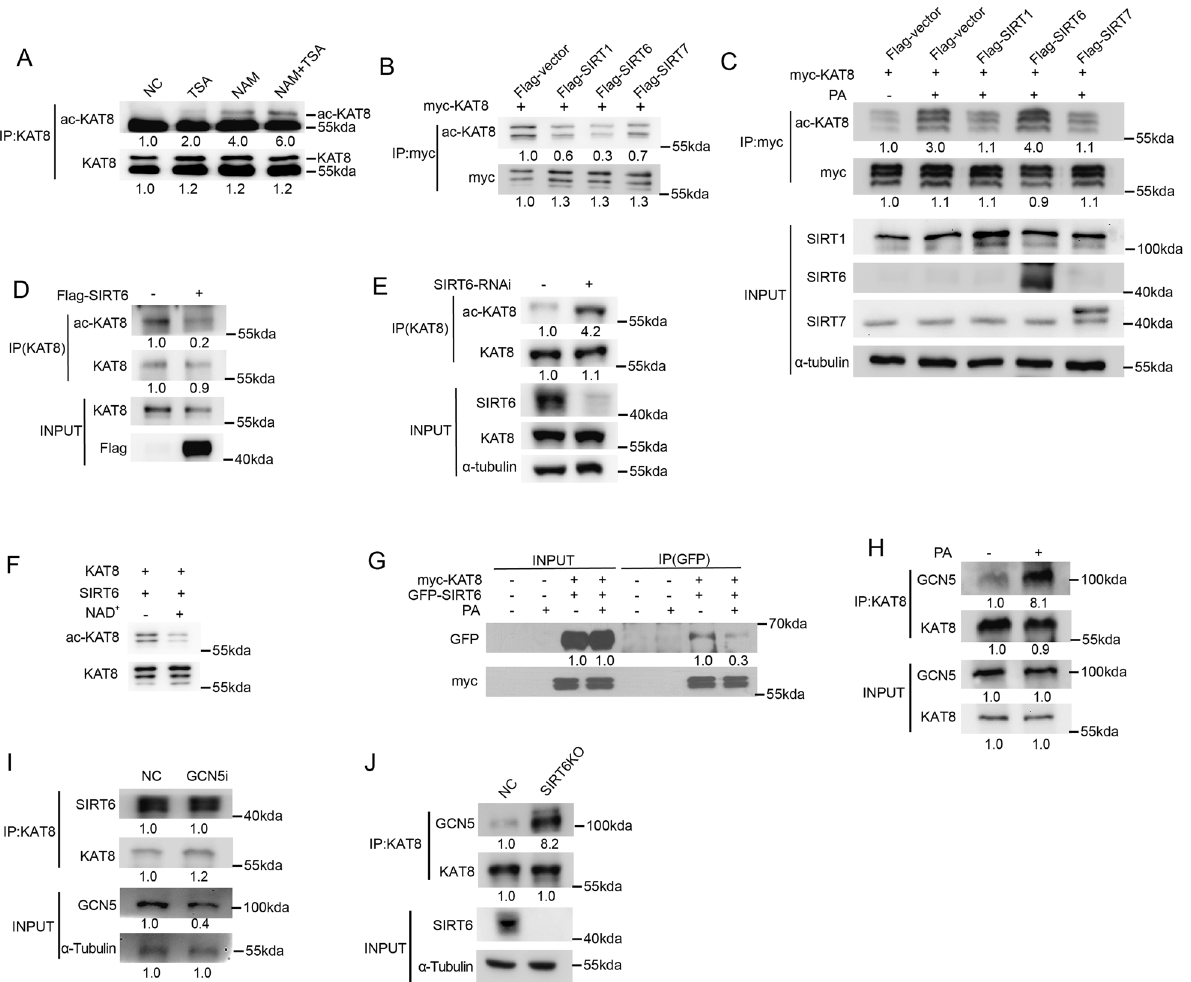
Fig. 3 SIRT6 is a deacetylase of KAT8 and is responsible for KAT8 acetylation. A HCT116 cells were treated with 1 μ M TSA or 5 mM NAM for 8 h and then proteins were extracted for Co-IP assay to detect the level of KAT8 acetylation. B HCT116 cells were co-transfected with myc- KAT8, Flag-SIRT1, Flag-SIRT6 or Flag-SIRT7, and then proteins were extracted for Co-IP to detect the level of KAT8 acetylation. C HCT116 cells were co-transfected with the plasmids above, and then treated with PA at 0.2 mM for 24 h. Proteins were extracted for Co-IP to detect the level of KAT8 acetylation. D , E HCT116 cells were transfected with Flag-SIRT6 ( D ) or SIRT6 siRNA ( E) , and proteins were extracted for Co-IP to detect the level of KAT8 acetylation. F myc-KAT8 and Flag-SIRT6 were co-transfected into HCT116 cells, and then KAT8 and SIRT6 proteins were puri fi ed to perform in vitro deacetylation assay. G , H HCT116 cells were co-transfected with GFP-SIRT6 ( G ) or Flag-GCN5 ( H ) and myc-KAT8, and then treated with PA at 0.2 mM for 24 h. Cell lysates were extracted for Co-IP assay to detect the exogenous interaction between SIRT6 ( G ) /GCN5 ( H ) and KAT8. I HCT116 was transfected with GCN5 siRNA or non-speci fi c RNA as control, protein was then extracted for Co-IP to detect the endogenous interaction between KAT8 and SIRT6. J HCT116 SIRT6-KO cells were extracted for Co-IP to detect the endogenous interaction between KAT8 and